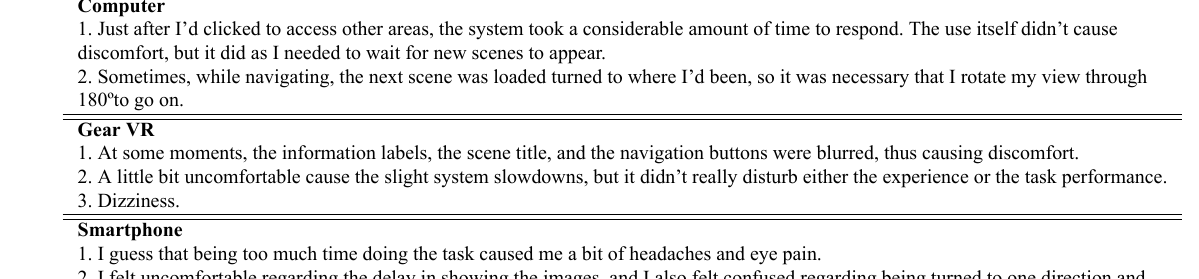
Table 9. Answers from all participants for question Q14 of the adapted SEQ after using all